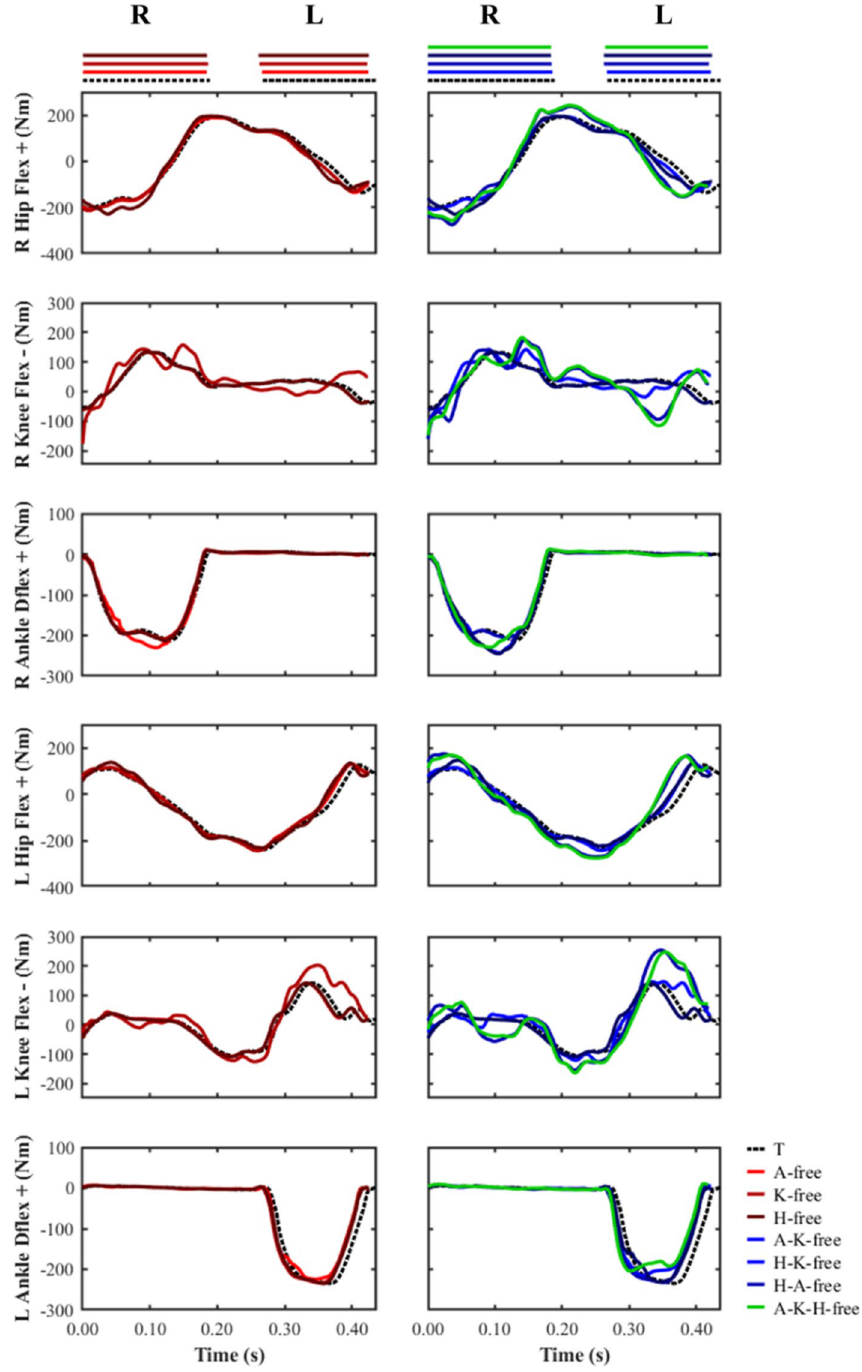
Figure 10. Right and left net ankle dorsiflexor-plantarflexor moments, and knee and hip flexor–extensor moments from right foot touchdown to left foot take-off for the data-tracking (T) and predictive simulations (A-free, K-free, H-free, A-K-free, H-K-free, H-A-free, A-K-H-free). The horizontal bars at the top of the figure indicate the periods of right (R) and left (L) stance. The outputs from the simulations were not plotted on the same set of axes to avoid interpretability and visualisation